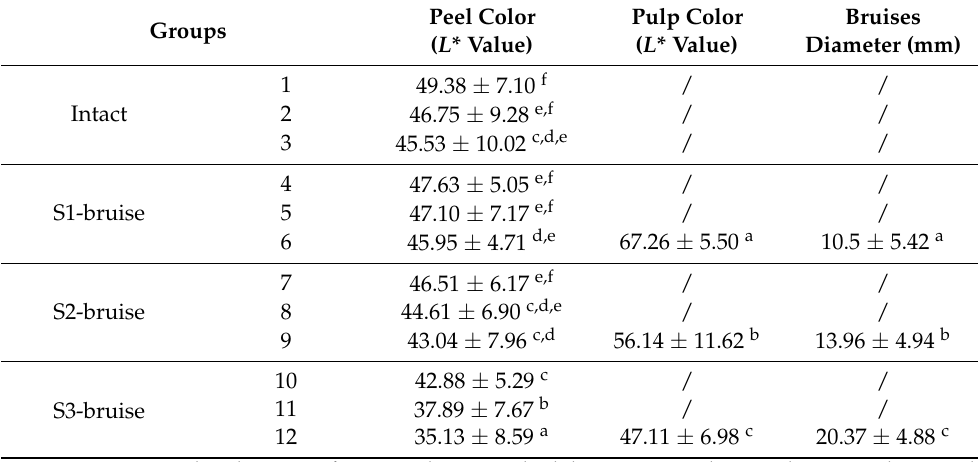
Table 2. Means and standard deviations of the quality parameters for different groups of peaches